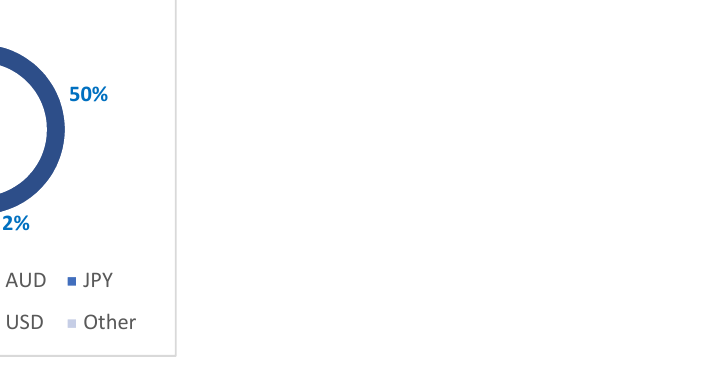
Figure 6. Global Bond Issuance Volumes, YTD 2021, Breakdown by Currency (Janse and Bradford 2021).